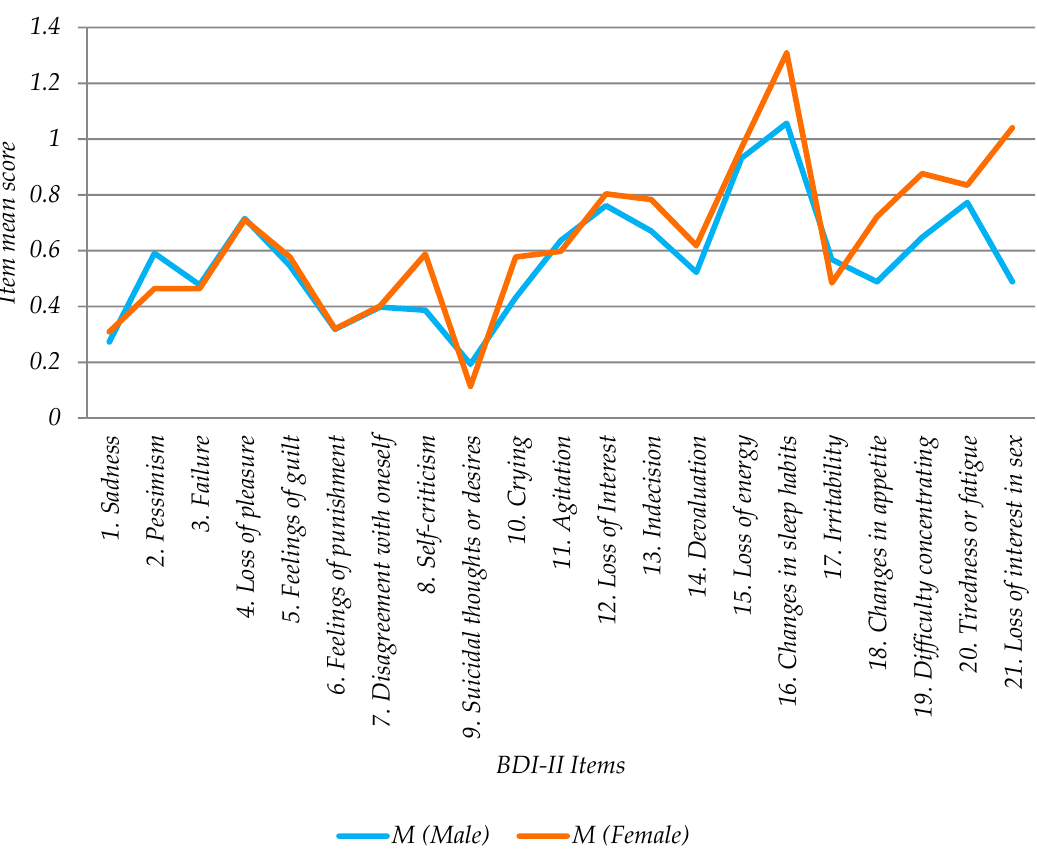
Figure 9. Mean scores (M) of BDI-II responses by gender.